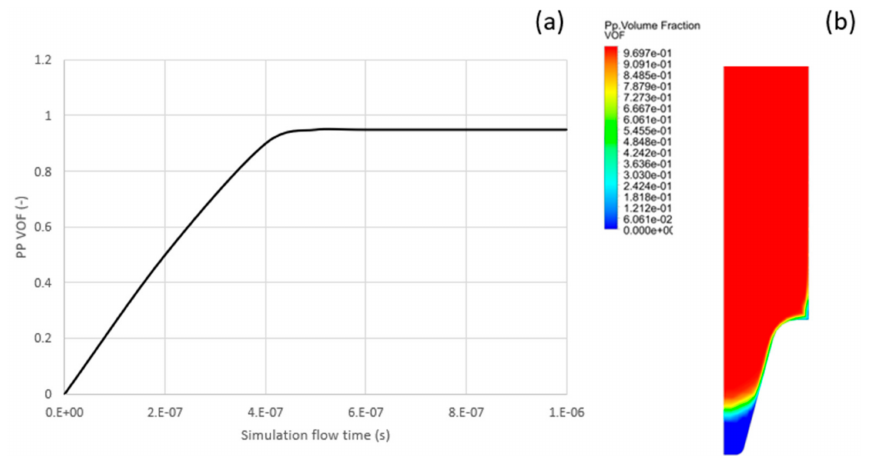
Figure 5. Fluent results showing ( a ) VOF versus time, and ( b ) VOF at end of